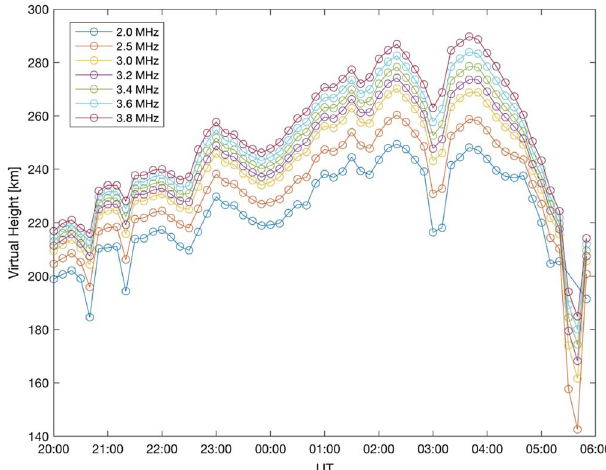
Fig. 12. Multiple traces from the ionosonde in Chilton (UK) recorded between 20:00 18 August 2013 and 06:00 19 August 2013.